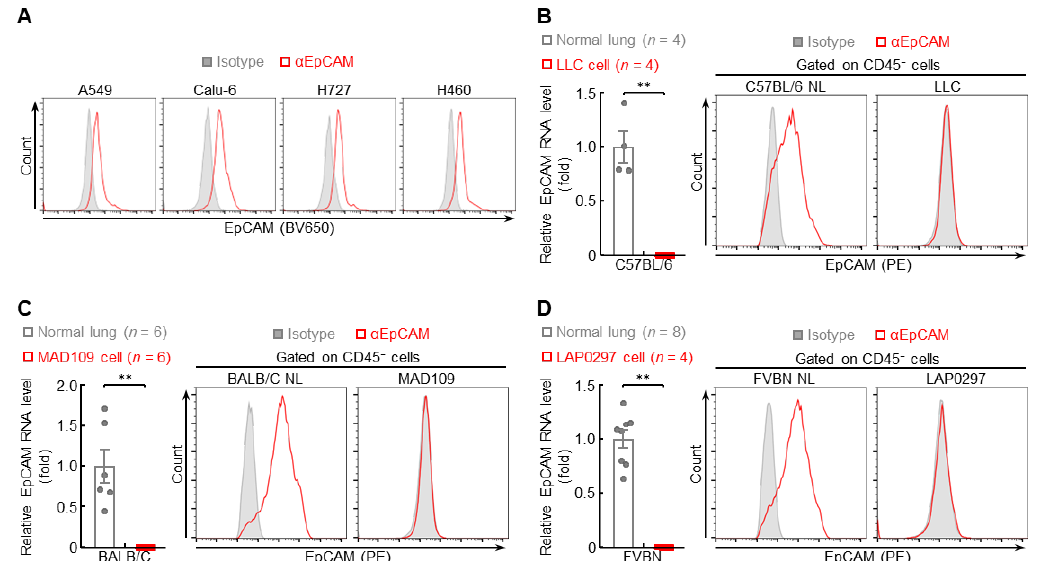
Figure 5. EpCAM expression is repressed in highly metastatic lung cancer cells. ( A ) FACS data showing decreased EpCAM protein expression in human highly metastatic lung cancer cells ( n = 3). ( B – D ) qPCR and FACS data showing repressed EpCAM expression in murine highly metastatic lung cancer cells (FACS: n = 4). Data are representative of at least three independent experiments with similar results. Student’s t test (two-tailed, unpaired) was performed. Data represent means ± SEM ( B – D ). ** p < 0.01.